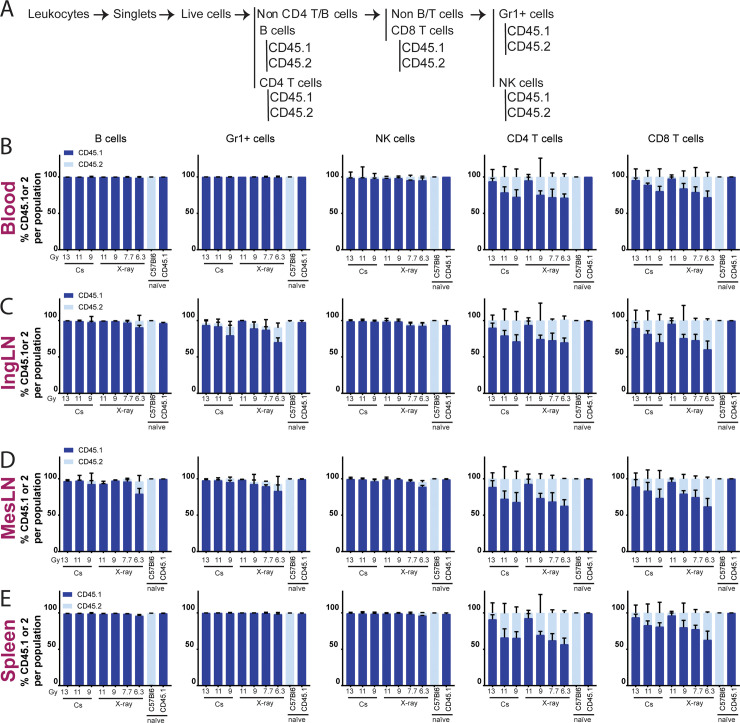
The degree of chimerism depends upon irradiation dose.A) Schematic illustration of flow cytometry gating tree, gating layout can be seen in S1B Fig. Percentages of chimerism in blood (B), IngLN (C), MesLN (D) and spleen (E) after Cs-137 irradiation at doses 9, 11 and 13 Gy or X-ray irradiation at doses 6.3, 7.7, 9 and 11 Gy. CD45.1 positive cells come from the donor mice and CD45.2 cells are remnants of the recipients own cells. Naïve mice have not been exposed to any treatment. In all bar graphs, the bar indicates the mean and error bars indicate the standard error of mean. Based on two-way ANOVA, irradiation modality did not come out as an independent source of variation in the data for any of the tissues or cell subsets analyzed, although there was a significant interaction effect (P = or P<0.0001 in all cases).